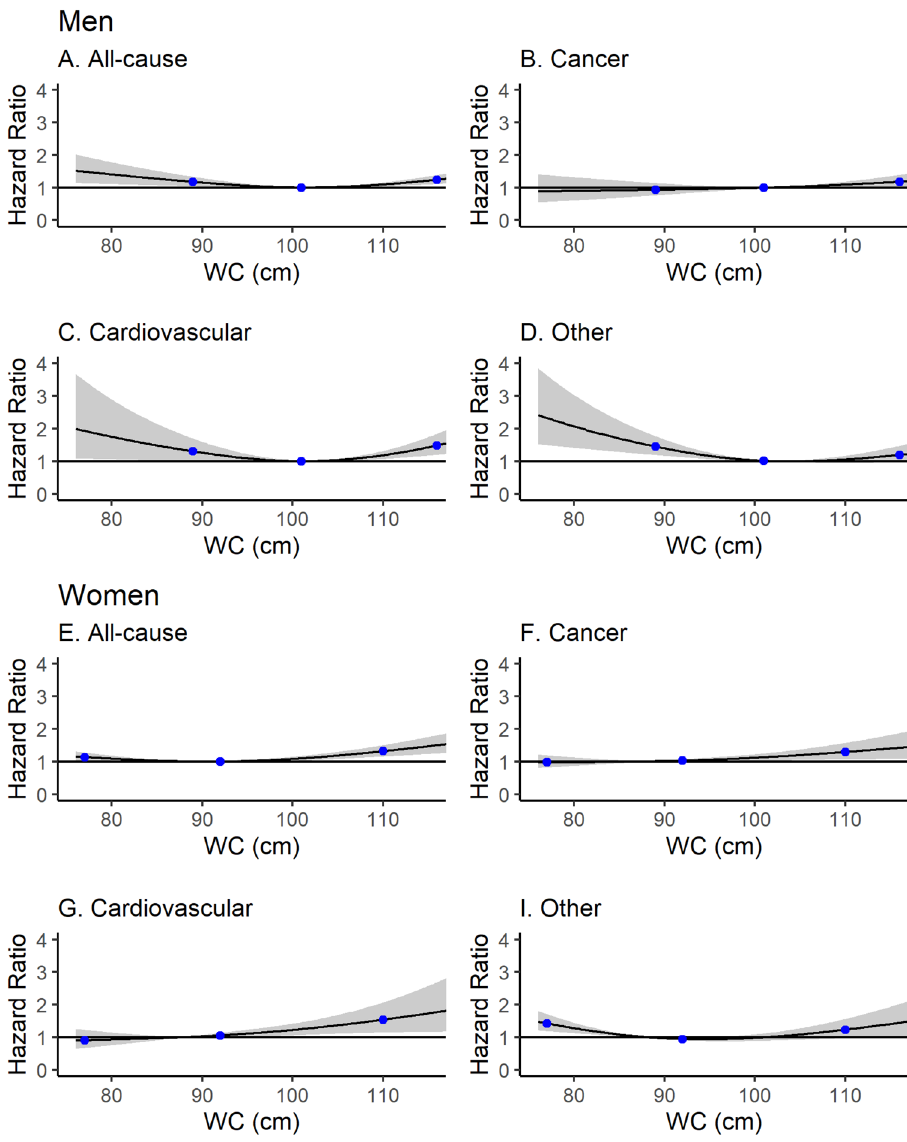
Figure 2. Hazard ratio for all-cause mortality, cancer mortality, cardiovascular mortality, and other mortality as a function of waist circumference (WC) in men ( A – D ) and women ( E – H ). Restricted cubic spline with knots at 89, 101, 116 cm (men) and 77, 92, 110 cm (women). Hazard ratios are indicated by the solid lines and 95% confidence intervals by shaded